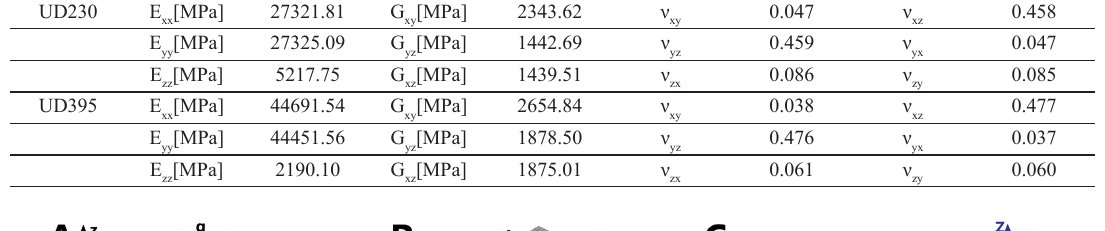
Table 3. Mechanical properties of the homogenized material.